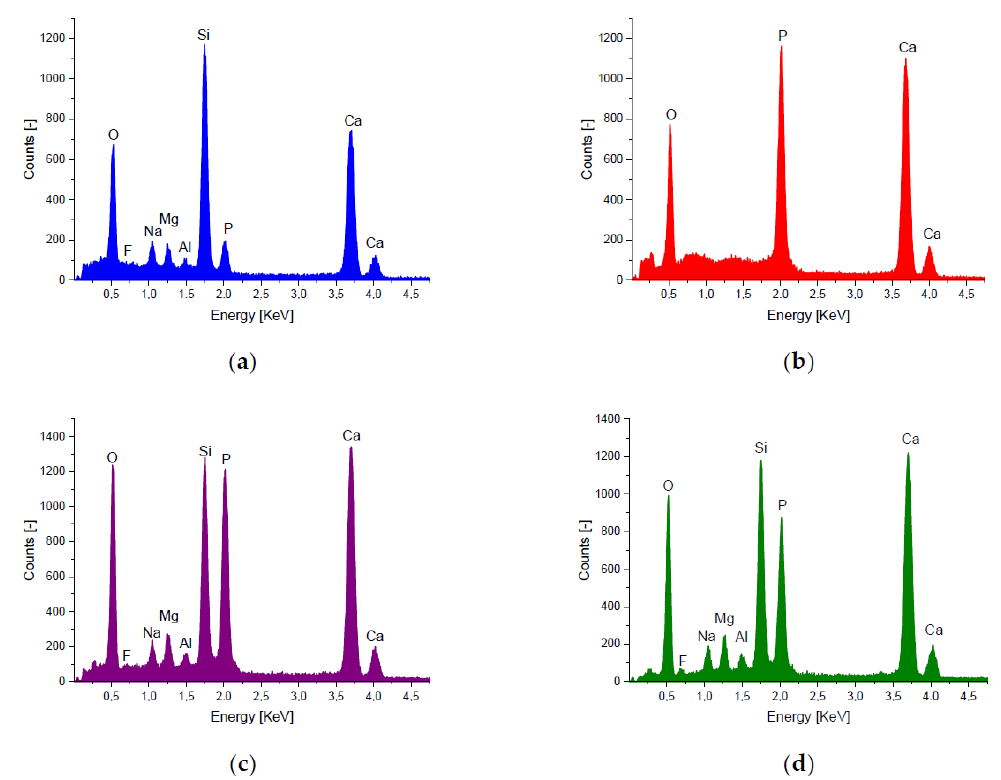
Figure 2. EDX Spectra of 3D printed Scaffolds: ( a ) BG; ( b ) β-TCP; ( c ) 50/50; and ( d ) 70/30; performed as area scan (area 0.81 mm 2 ). Table 2. Mean elemental composition for the samples (ZAF